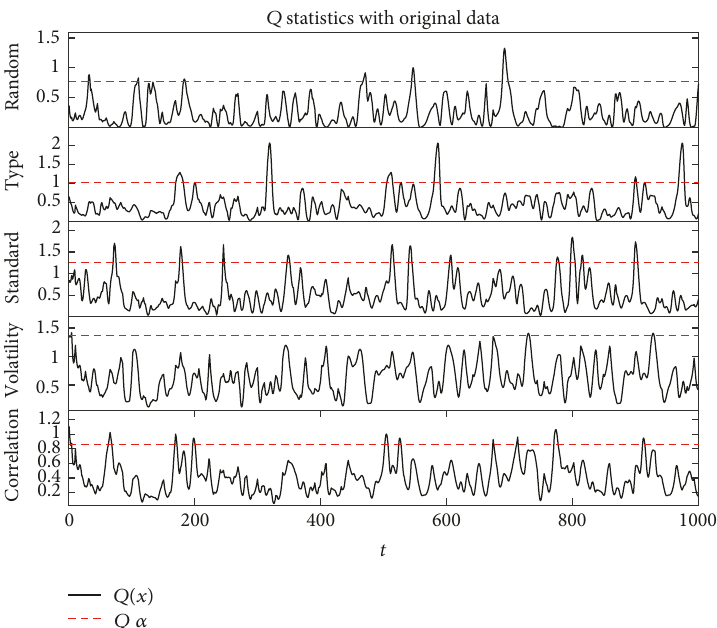
Figure 7: 𝑄 statistics with preprocessed data in 5 PCA